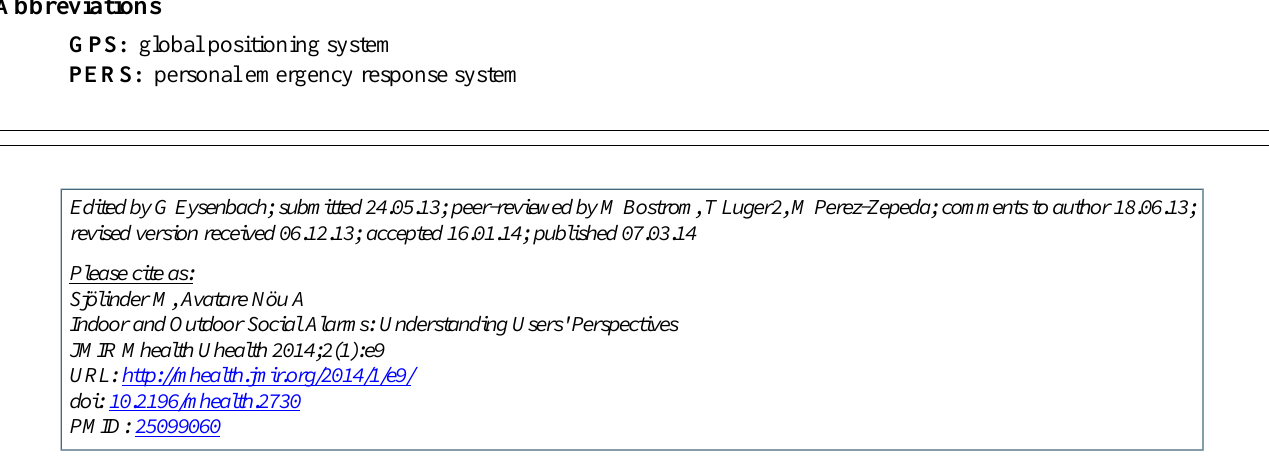
GPS: global positioning